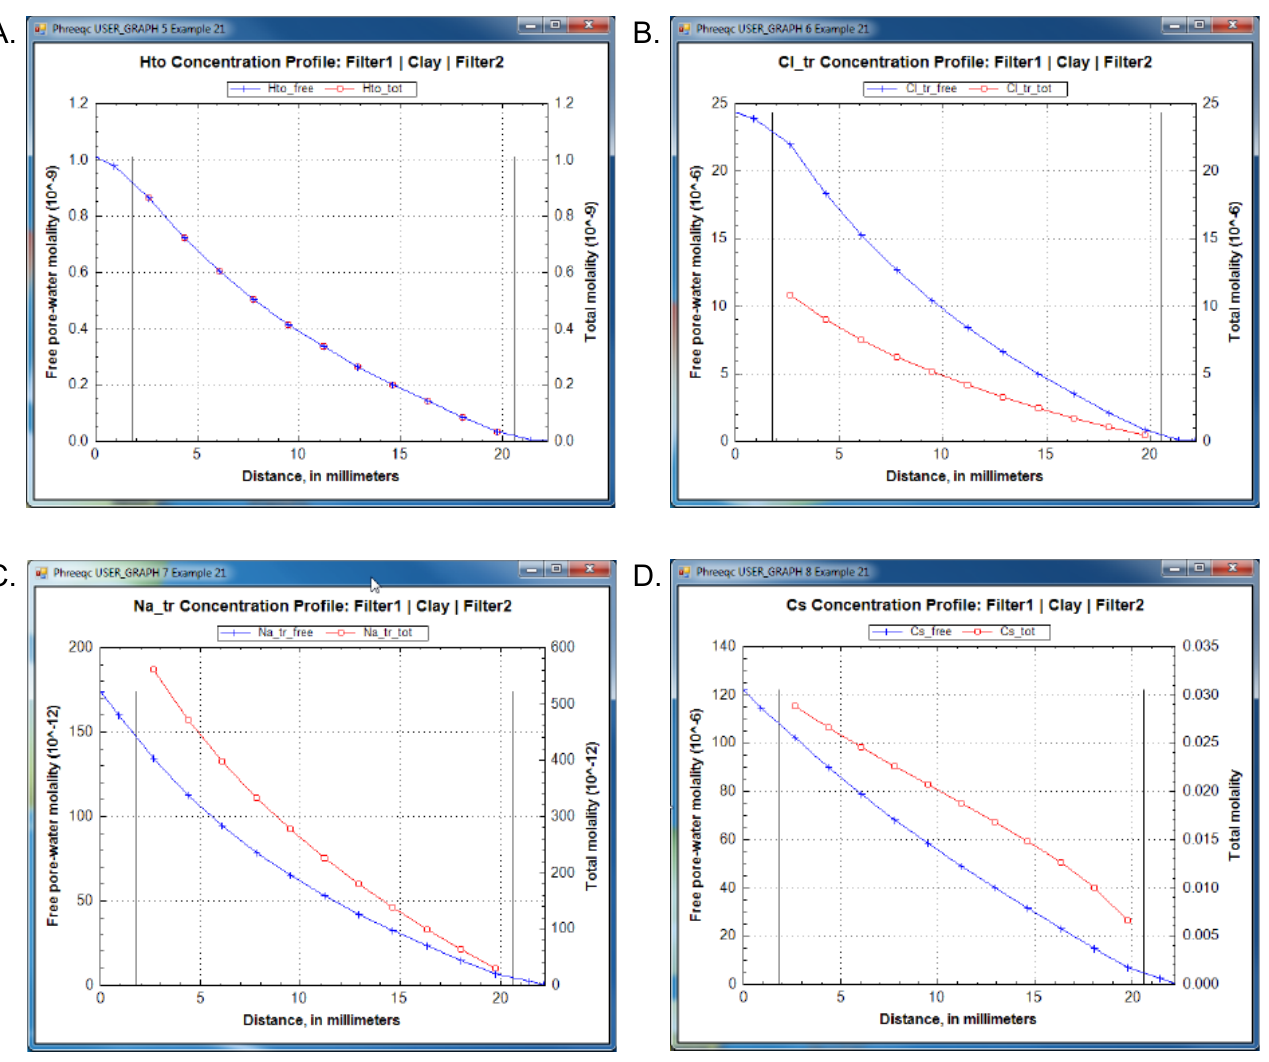
Figure 25. Concentration profiles in the filters and free pore water in the clay (blue), and total moles per kilogram water in the double-layer water in the clay (red) at the end of the calculations in the radial cell for (A) HTO, (B) 36 Cl - , (C) 22 Na + , and (D) Cs + . Vertical lines indicate the positions of the filters.